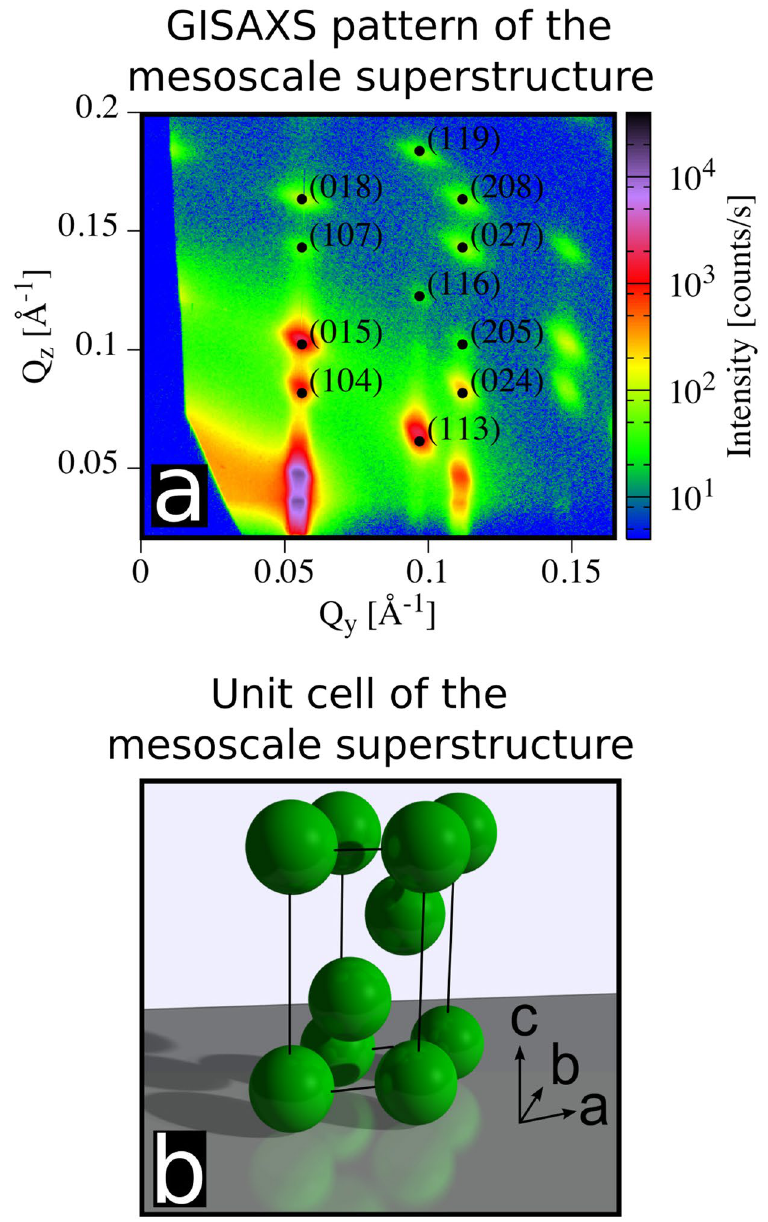
Figure 3. GISAXS pattern and unit cell structure of the drop cast nanoparticle assemblies formed by slow evaporation. ( a ) Selected well-defined peaks of the GISAXS pattern are indexed to a R 3 m structure, which represents the final structure for all investigated samples. (b) Illustration of the rhombrohedral unit cell as defined by the GISAXS analysis (see Fig. 6 for unit cell